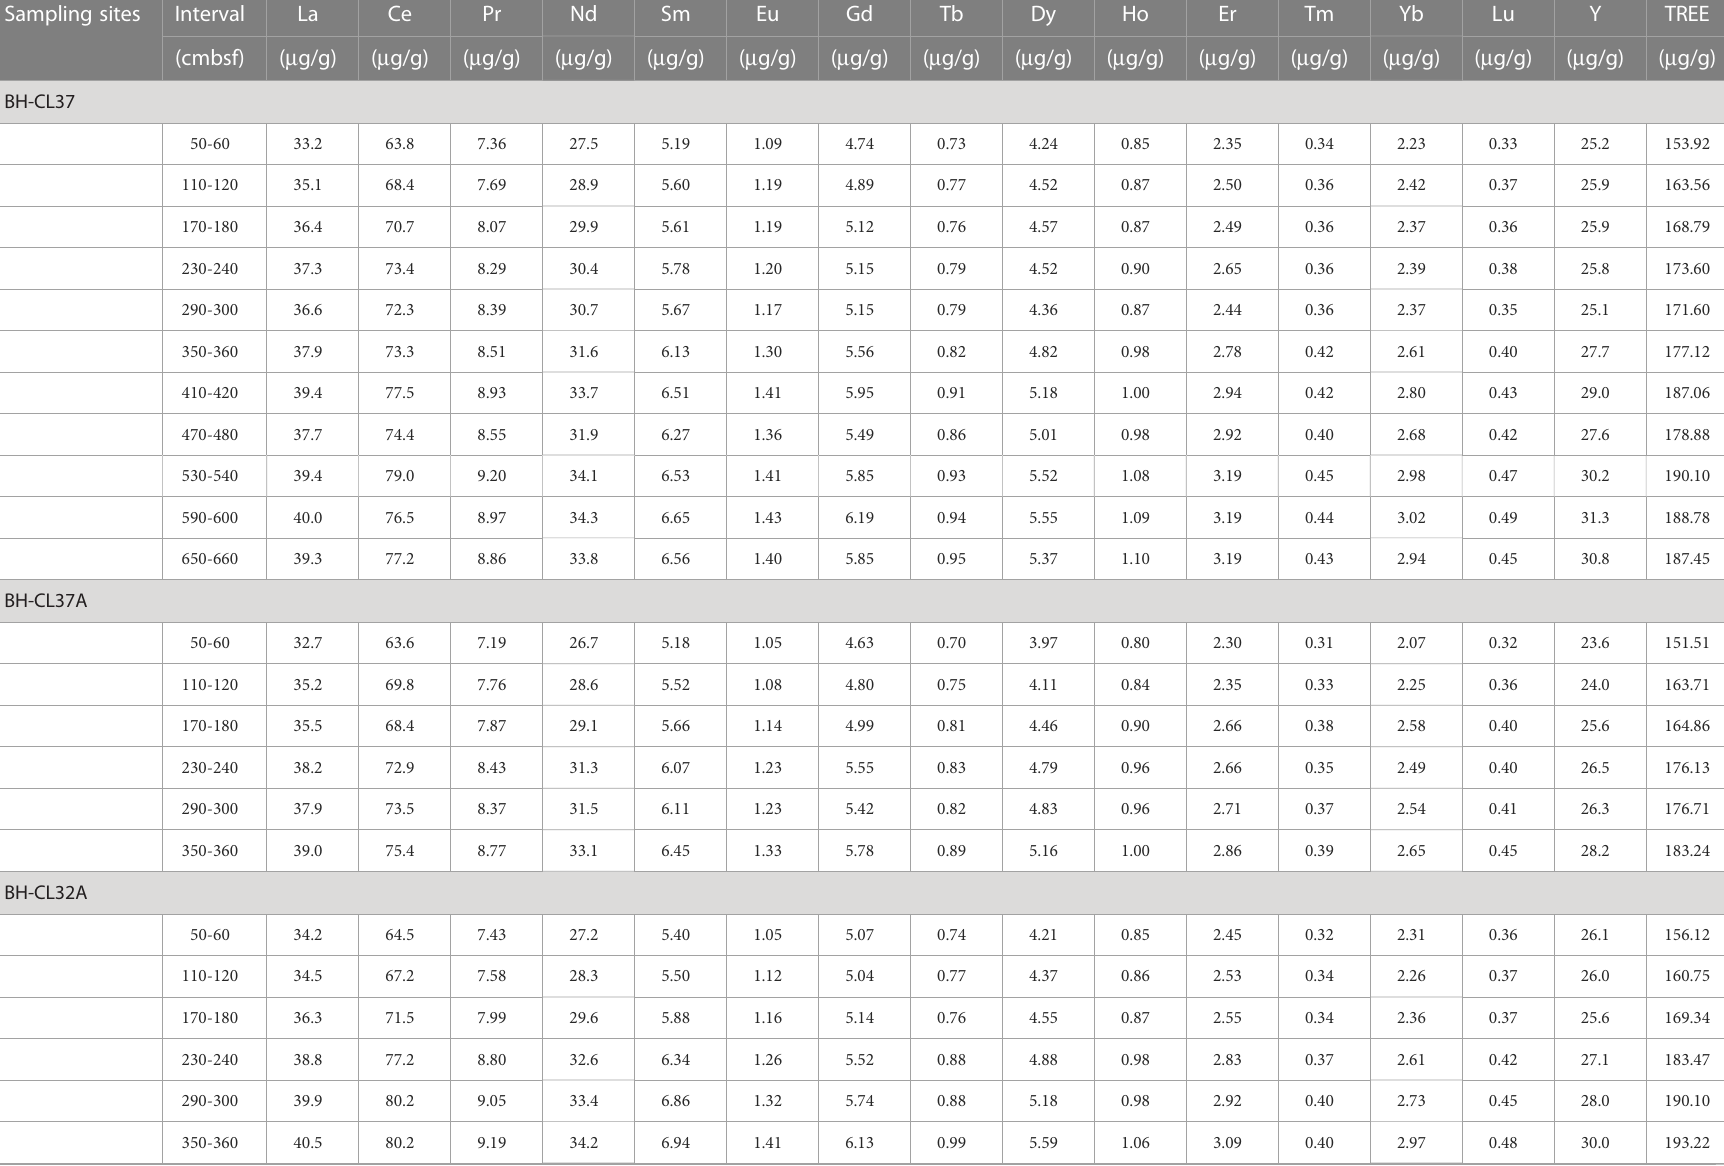
TABLE 5 Concentration of rare earth element in sediments. Sampling